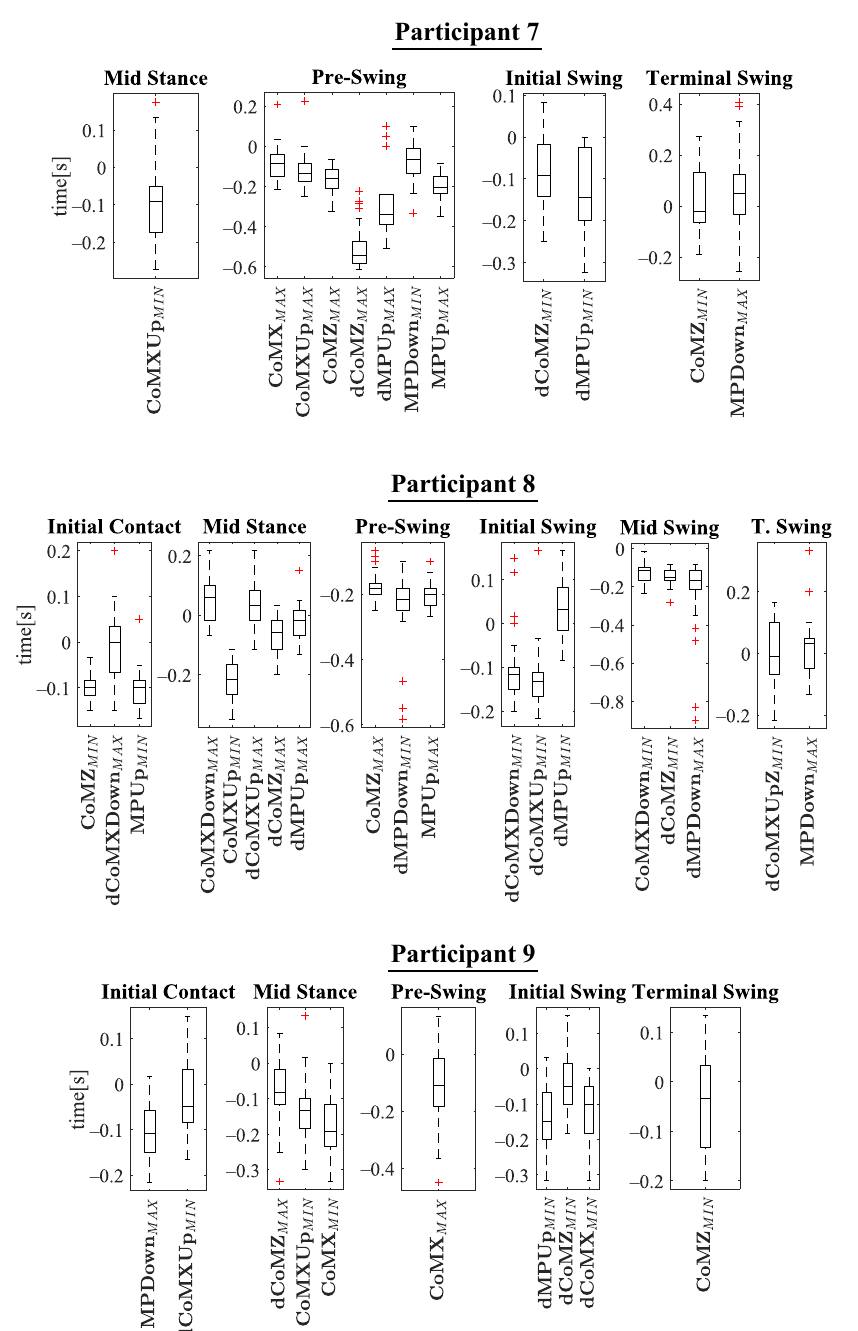
Figure 13. Experimental results for P7–P9. In the y -axis, 0 s is the time corresponding to the phase beginning. Negative time values mean that the event appears before the phase, and positive values that it occurs after the phase has